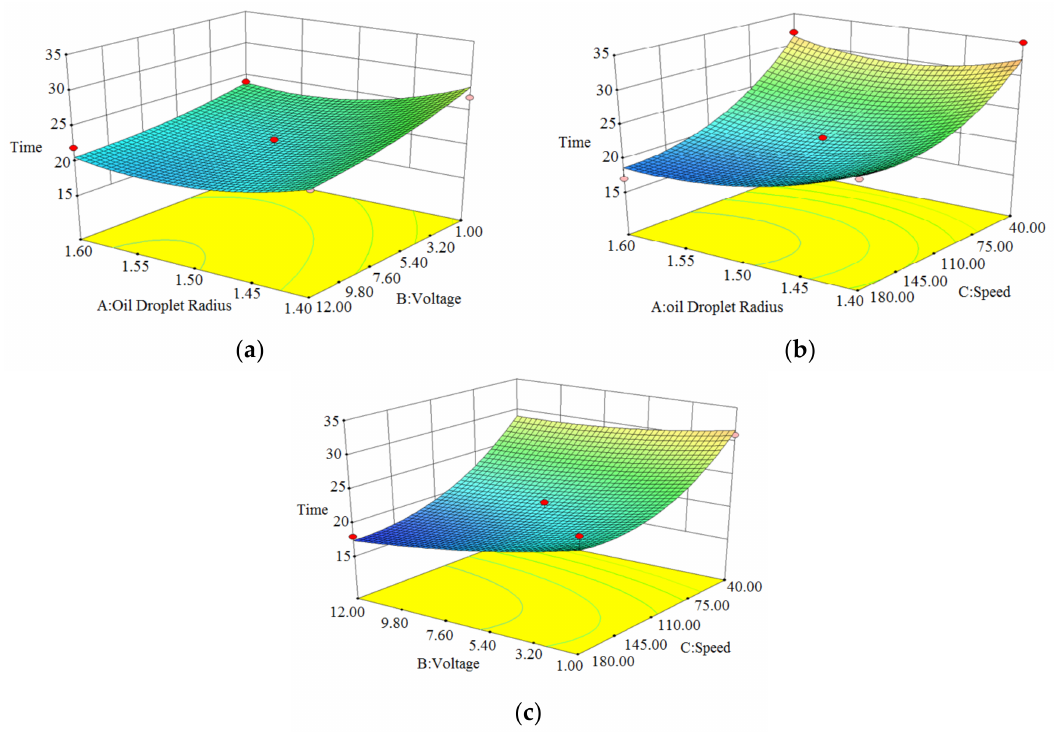
Figure 11. Response surface diagram of interaction of various factors. ( a ) Radius and voltage, ( b ) radius and speed, ( c ) voltage and